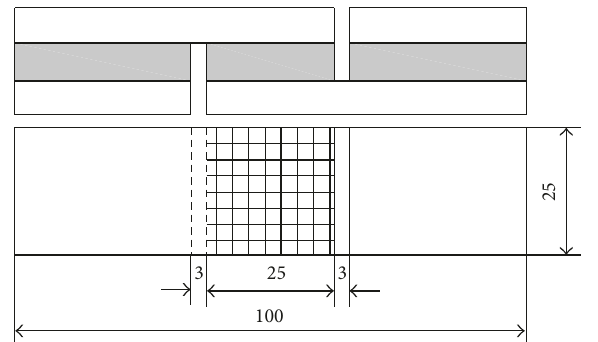
Figure 1: Test sample size of